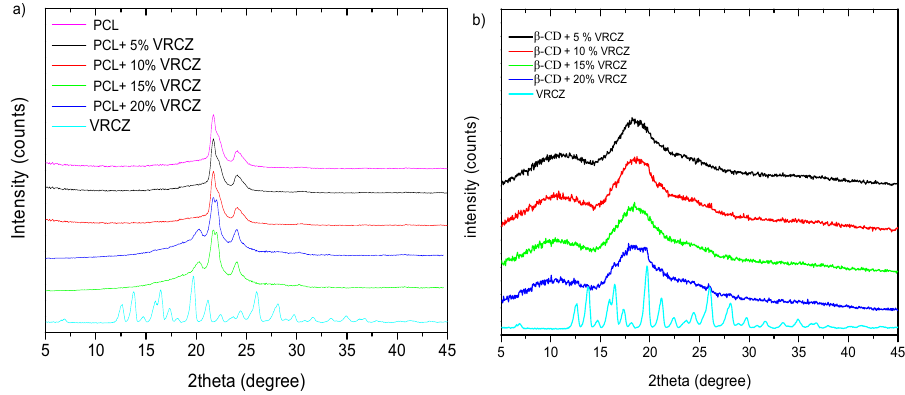
Figure 7. X-Ray diffraction patterns of ( a ) PCL fibers containing VRCZ, and ( b ) VRCZ inclusion Figure 7. X-ray diffraction patterns of ( a ) PCL fibers containing VRCZ; and ( b ) VRCZ inclusion complexes with β -CD. complexes with β